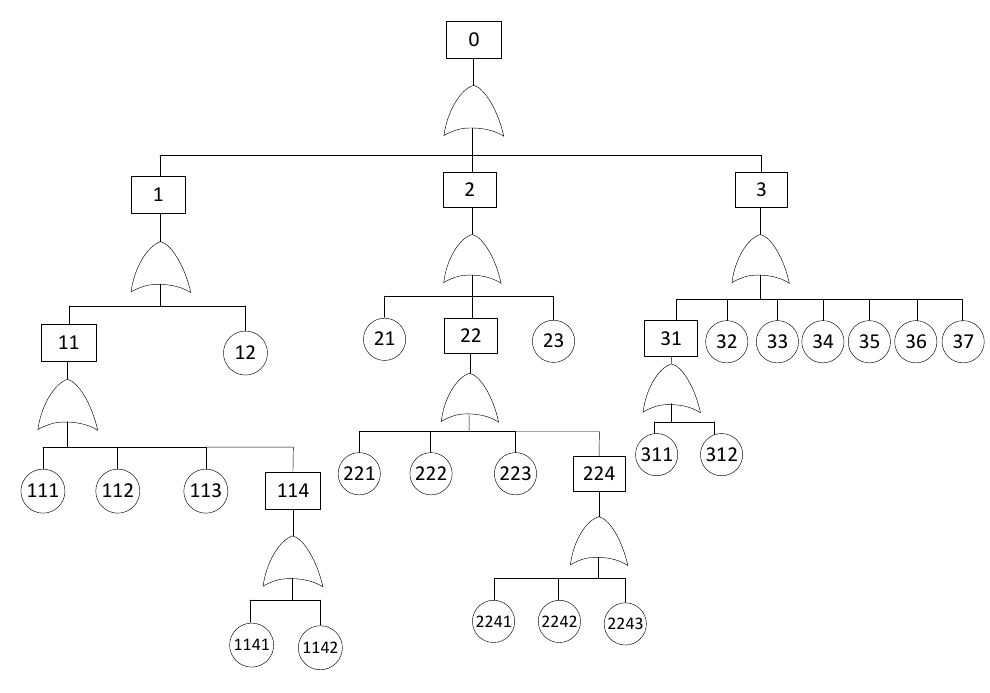
Figure 2. Monitoring system risk